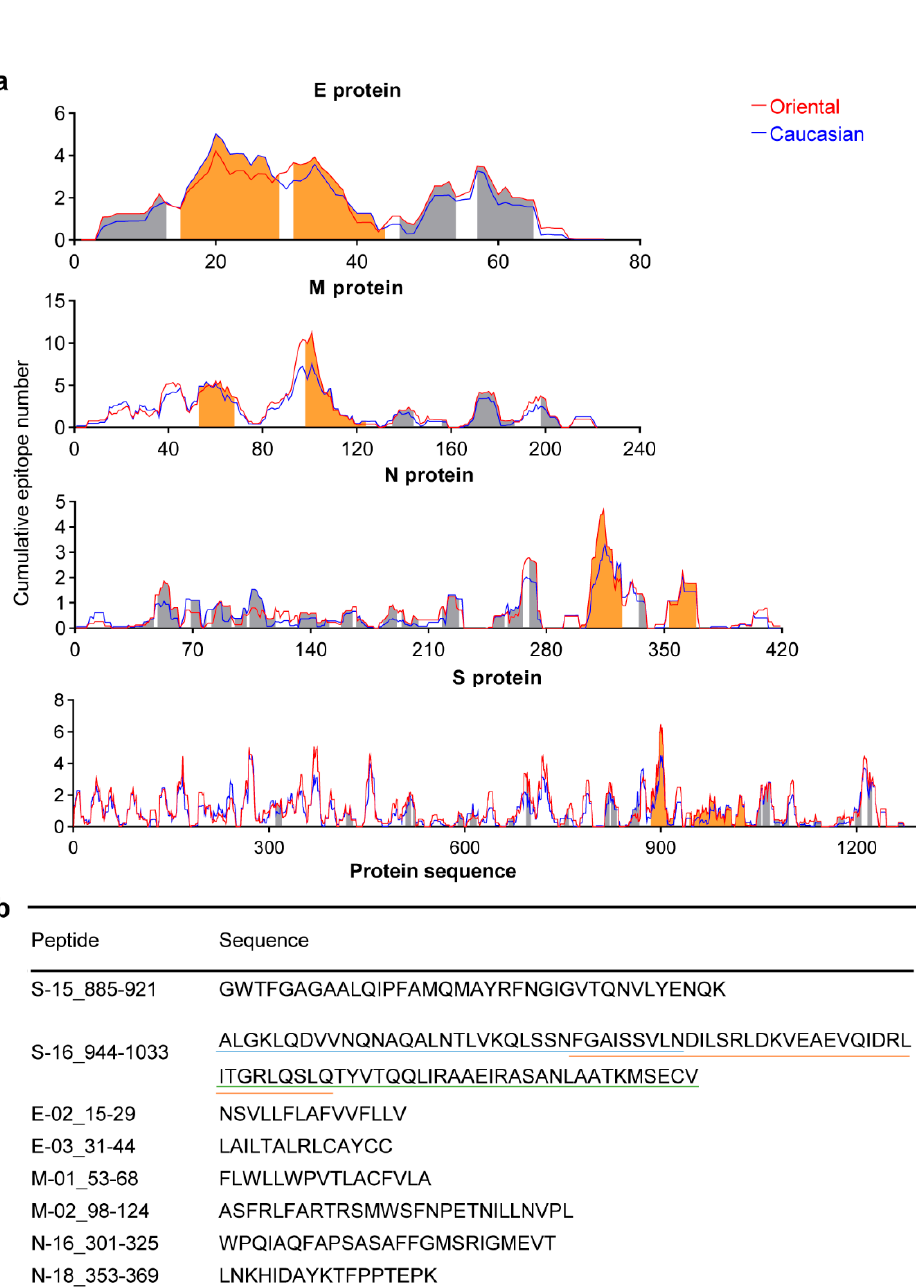
Figure 1. Selection of severe acute respiratory syndrome (SARS)-like viral conserved antigens. ( a ) the cumulative number of predicted major histocompatibility complex (MHC) class I epitopes in each amino acid of S, E, M, and N proteins for Oriental and Caucasian populations. NetMHCpan 4.0 was used for epitope prediction, and the number of epitopes was weighted for MHC alleles positive ratios. There was no significant difference between the two populations in the epitope curves of the four proteins. Shaded areas marked the conserved sequences among SARS-like viruses, of which the orange ones were selected as conserved antigens for the following study. ( b ) Sequences of the 8 selected conserved antigens in ( a ), with S16 being divided into three overlapping sequences. The synthesis of E2 and E3 failed because of the hydrophobicity. The combination of 8 synthetic peptides from S, M, N constituted the peptide